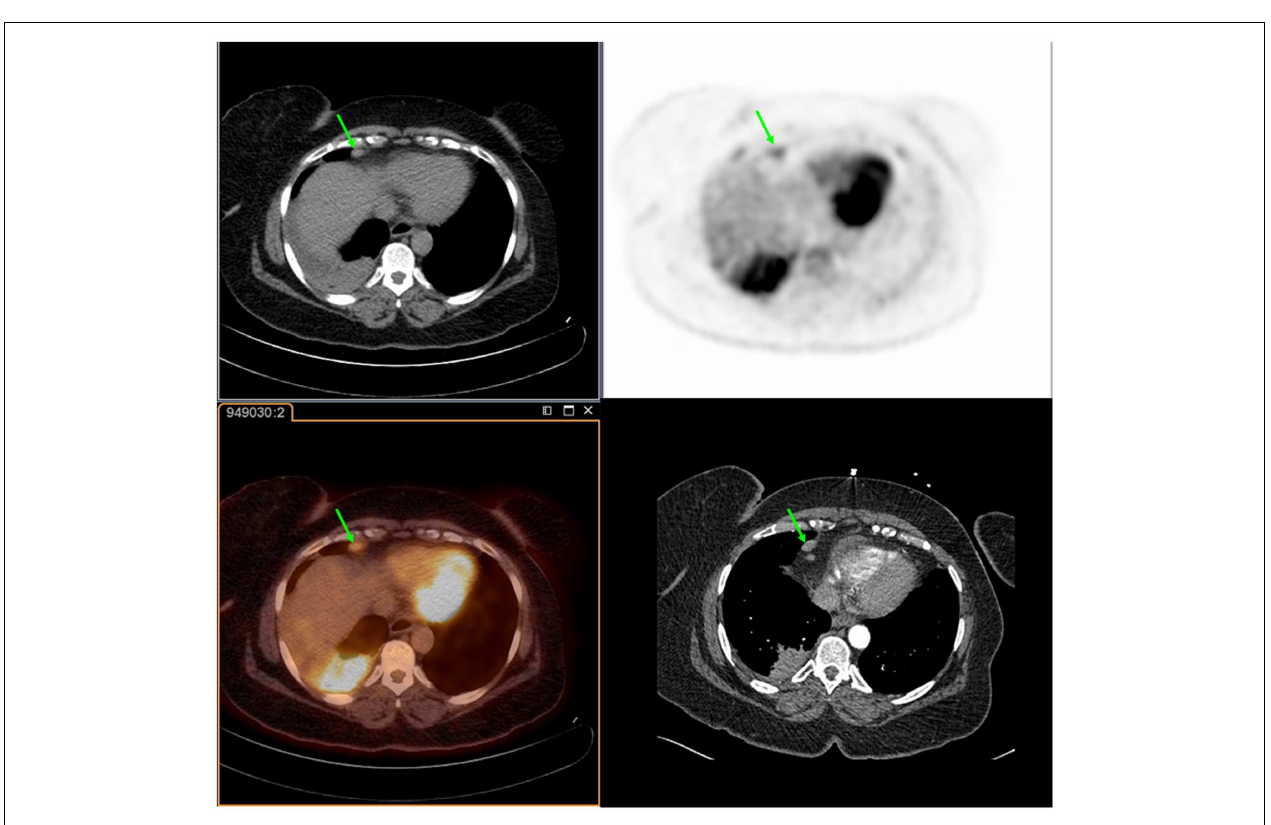
fused images (bottom left).These were not commented on in the contrast-enhanced CT (bottom right). Differences in the levels between the two studies are due to patient positioning and respiratory